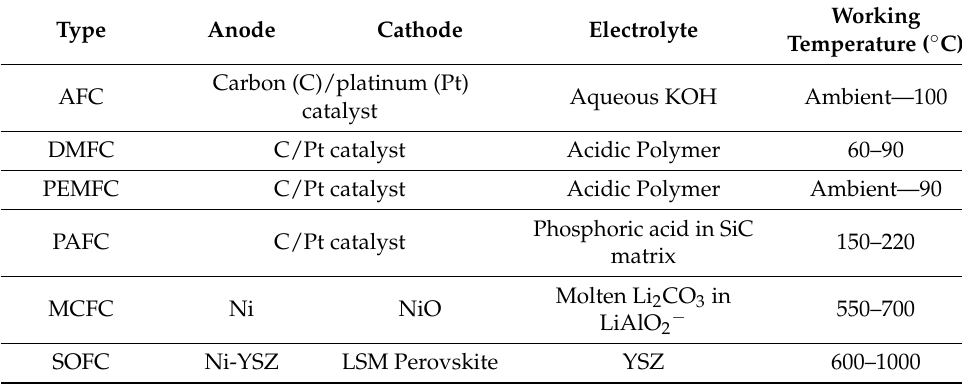
Table 1. Characteristics of various FC systems [20].